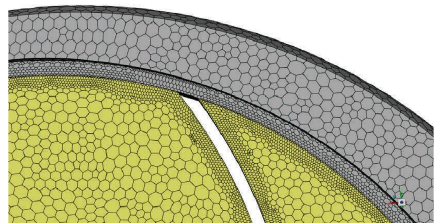
Figure 3: Boundary layer mesh